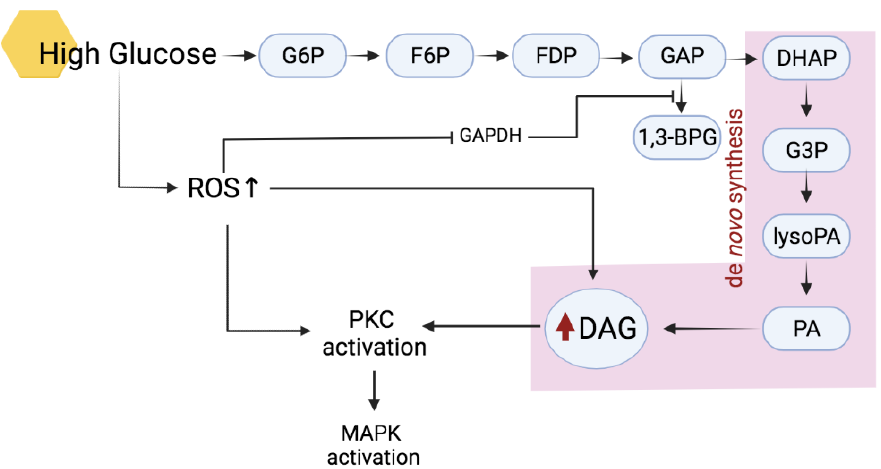
Figure 2. Mechanism of DAG–PKC activation. Hyperglycaemia induces mainly the de novo pathway of DAG synthesis from glucose to glycerol 3-phosphate with subsequent PKC activation. ROS, reactive oxygen species; DAG, diacylglycerol; DHAP, dihydroxyacetone phosphate; FDP, fructose 1,6-diphosphate; F6P, fructose 6-phosphate; GAP, glyceraldehyde 3-phosphate; G3P, glycerol 3-phosphate; G6P, glucose 6-phosphate; lysoPA, lysophosphatidic acid; PA, phosphatidic acid; PKC, protein kinase C; MAPK, mitogen-activated protein kinase. Arrows represent the subsequent event/product in the pathway; red arrow represents increased production.